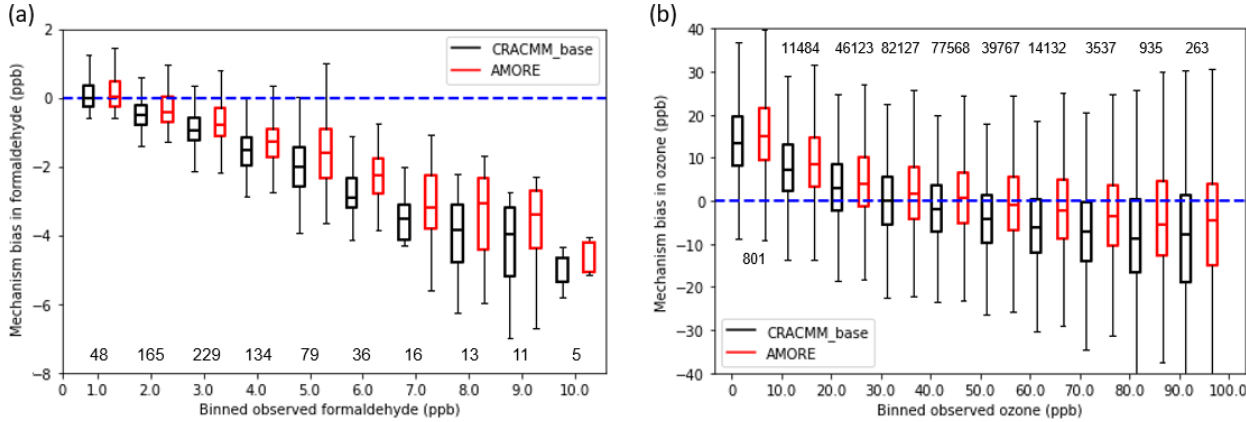
Figure 9. Binned mean bias of AMORE-Isoprene and baseline CRACMM for (a) formaldehyde and (b) ozone compared with AQS data for the northeastern US during summer 2018. Numbers for box plots indicate the number of data points in each observed